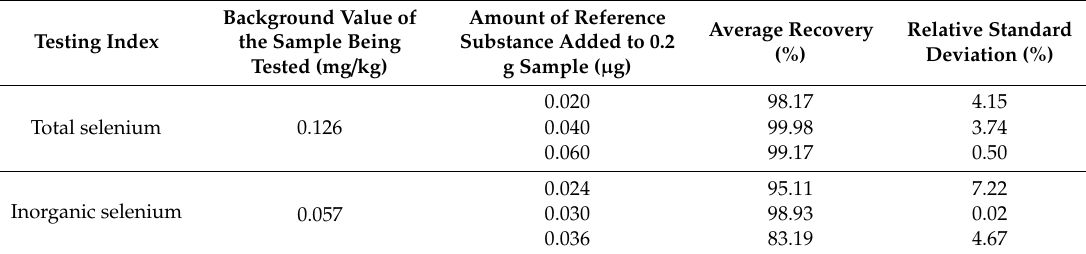
Table 1. Recovery and relative standard deviation of total selenium and inorganic